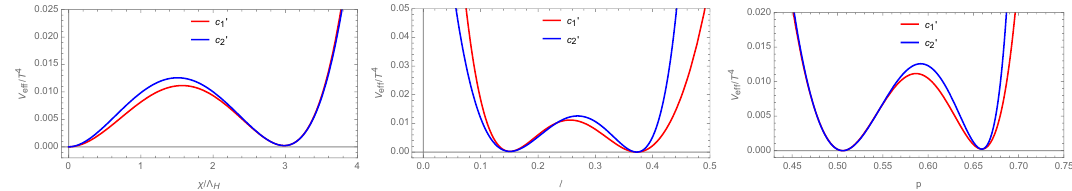
Figure 9 . The potential V e(cid:11) ( L; (cid:31); T ) =T 4 at T c; 4 = (cid:3) H = 6 : 670 as a function of (cid:31) (left), ‘ (center) and p (right) on the two di(cid:11)erent lines c 0 in (3.64) and (3.65).